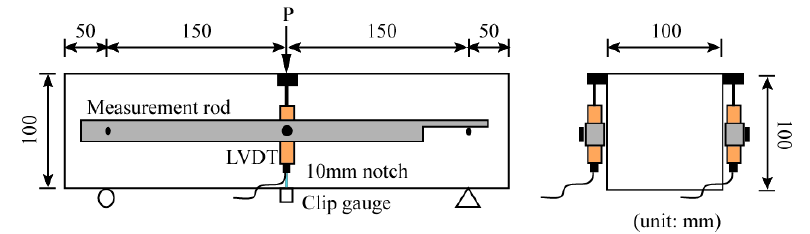
Figure 6. Setup of the flexural tensile test (three-point bending test with a notched beam).